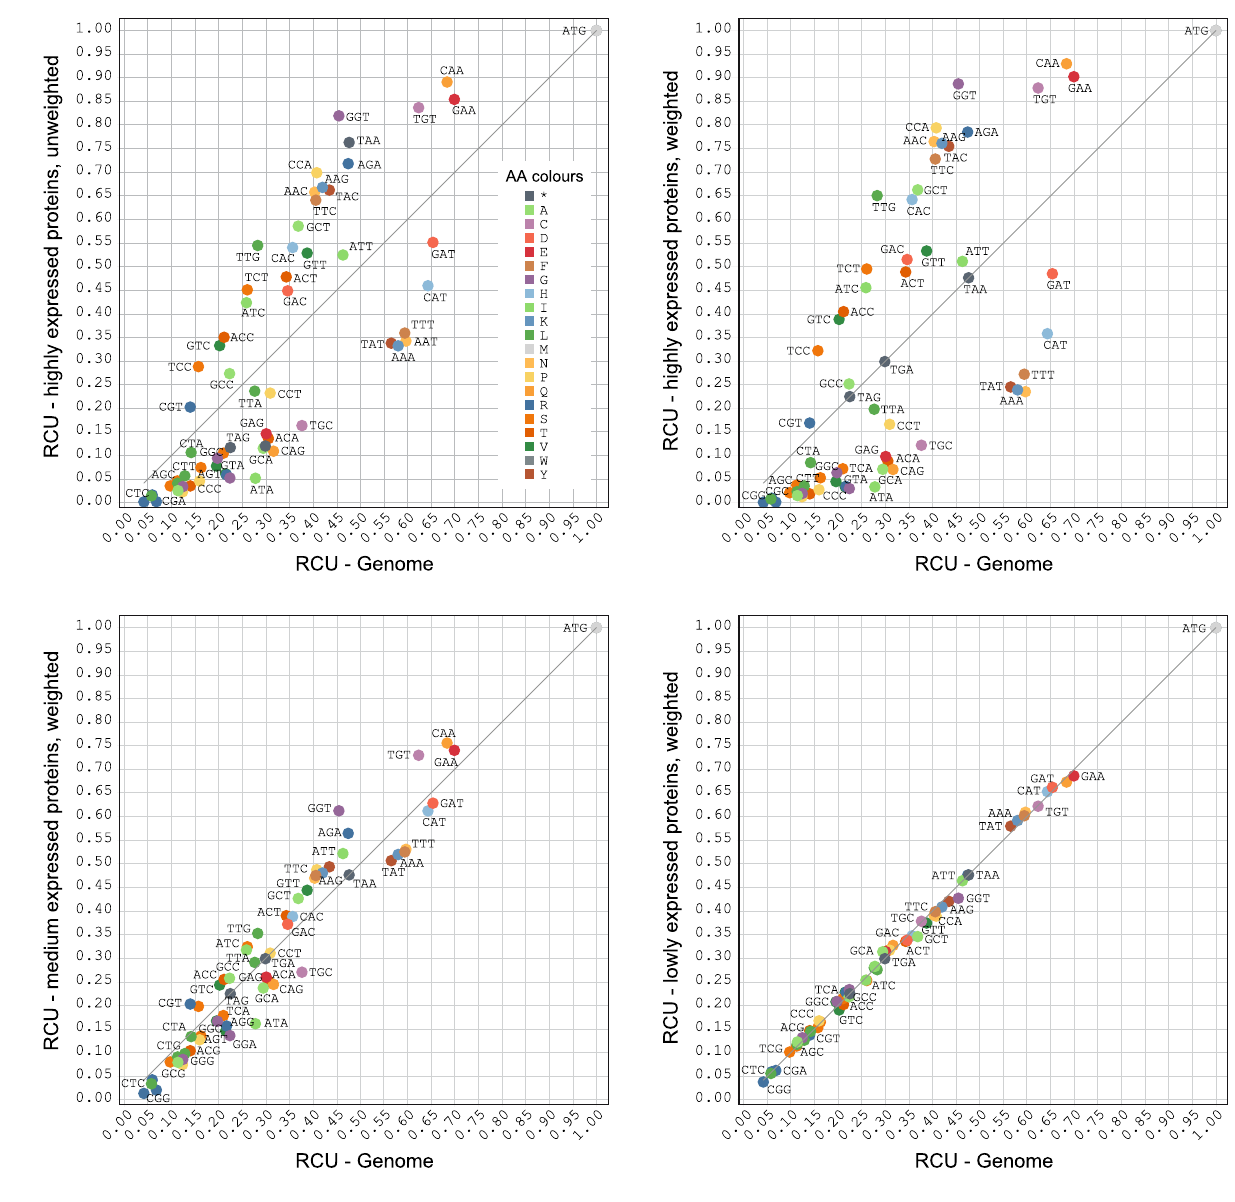
5024 least expressed proteins of S. cerevisiae plotted against the RCU of all predicted yeast genes (x-axis). For comparison, the RCUs of the highly expressed proteins are shown unweighted and weighted. Weighting means that each gene is multiplied by its absolute abundance as given by the PaxDB